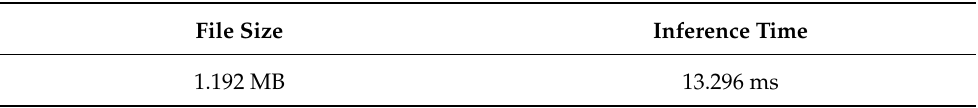
Figure 9. Experimental setup of our handheld device for real-time inference and display. Table 10. Computation cost in the real-time application, where the inference time is an average of 100